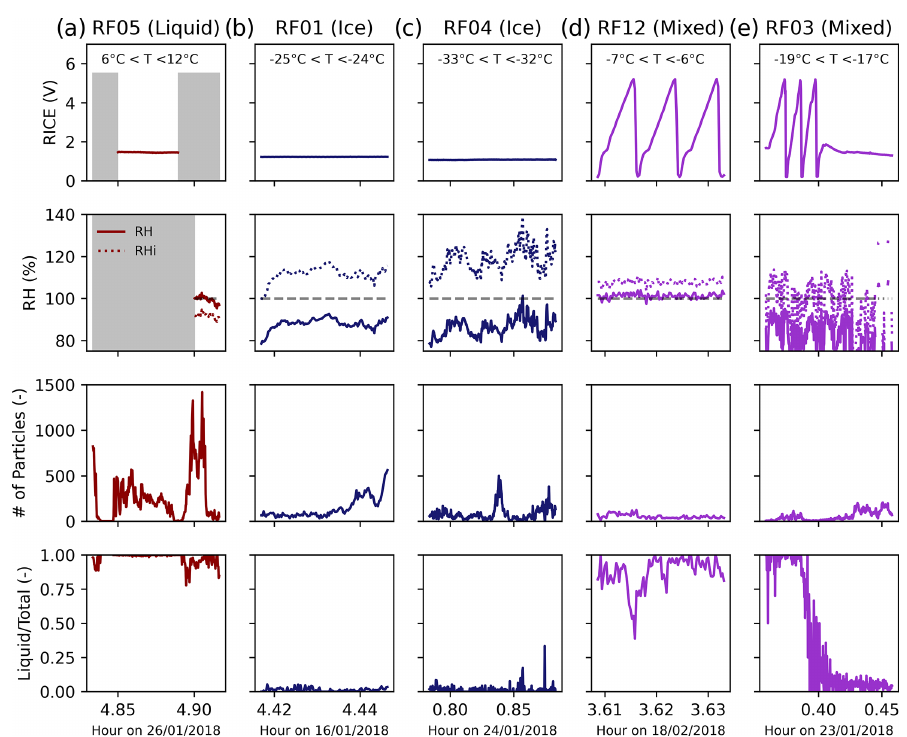
Figure 4. Time series of atmospheric parameters and particle properties for the liquid-only period (a) , the two ice-dominated periods (b, c) , and the two example mixed-phase periods (d, e) . Voltage from the RICE (row 1), relative humidity with respect to liquid (solid line) and ice (dashed line) (row 2), the number of particles that satisfy our selection criteria (row 3), and liquid fraction as determined by the UWILD algorithm (row 4) are shown for each flight period. A RICE response is expected when the supercooled water content exceeds 0.025gm − 3 . Missing data are indicated with grey. The temperature range sampled in each period is shown on the plot of RICE voltage in the top